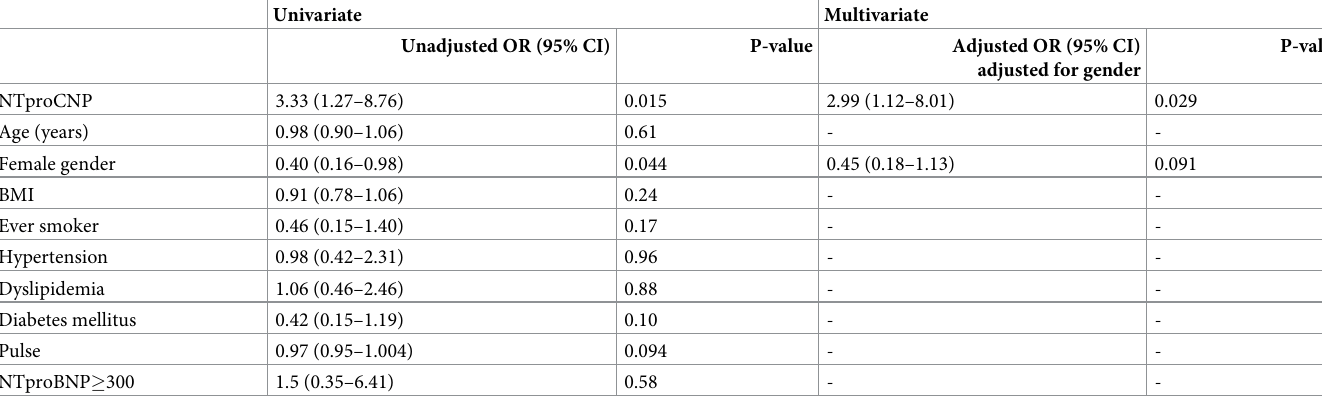
Table 2. Univariate and multivariate association with impaired myocardial